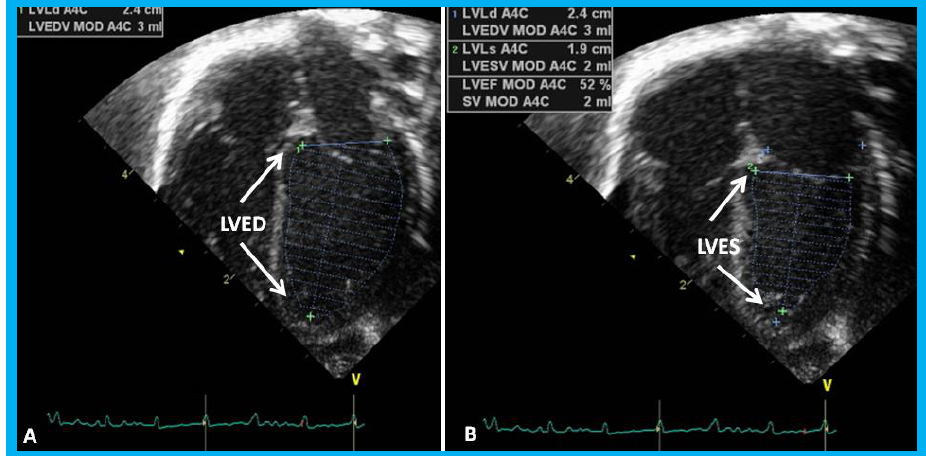
Figure 24. Apical four-chamber views of the left ventricle (LV) in end-diastole (LVED) in ( A ) and end-systole (LVES) in ( B ) demonstrating calculation of area shortening of the LV using Simpson’s rule: AS = (LVAd−LVAs)/LVAd (where AS is area shortening, LVAd is LV area in diastole, and LVAs is LV area in systole). The LV area shortening is 52% (see insert in ( B )); normal values are 40 to